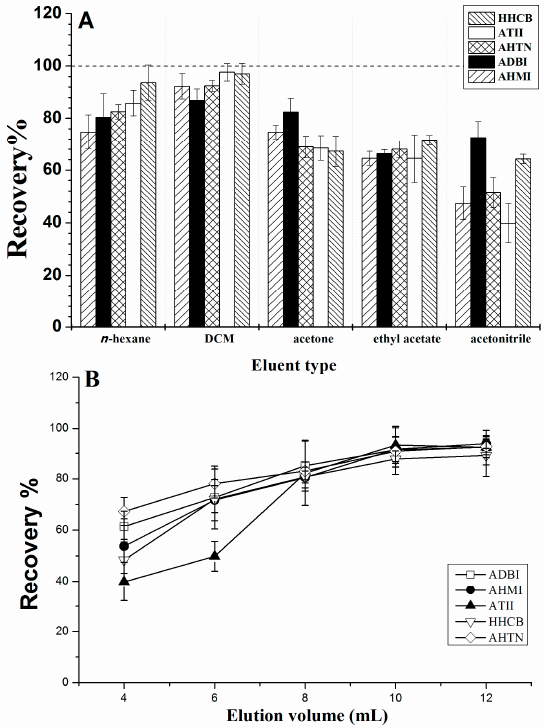
Figure 2. Optimization of ( A ) elution solvent and ( B ) elution volume for solid-phase extraction (SPE) of five polycyclic musks (PCMs) from water samples.